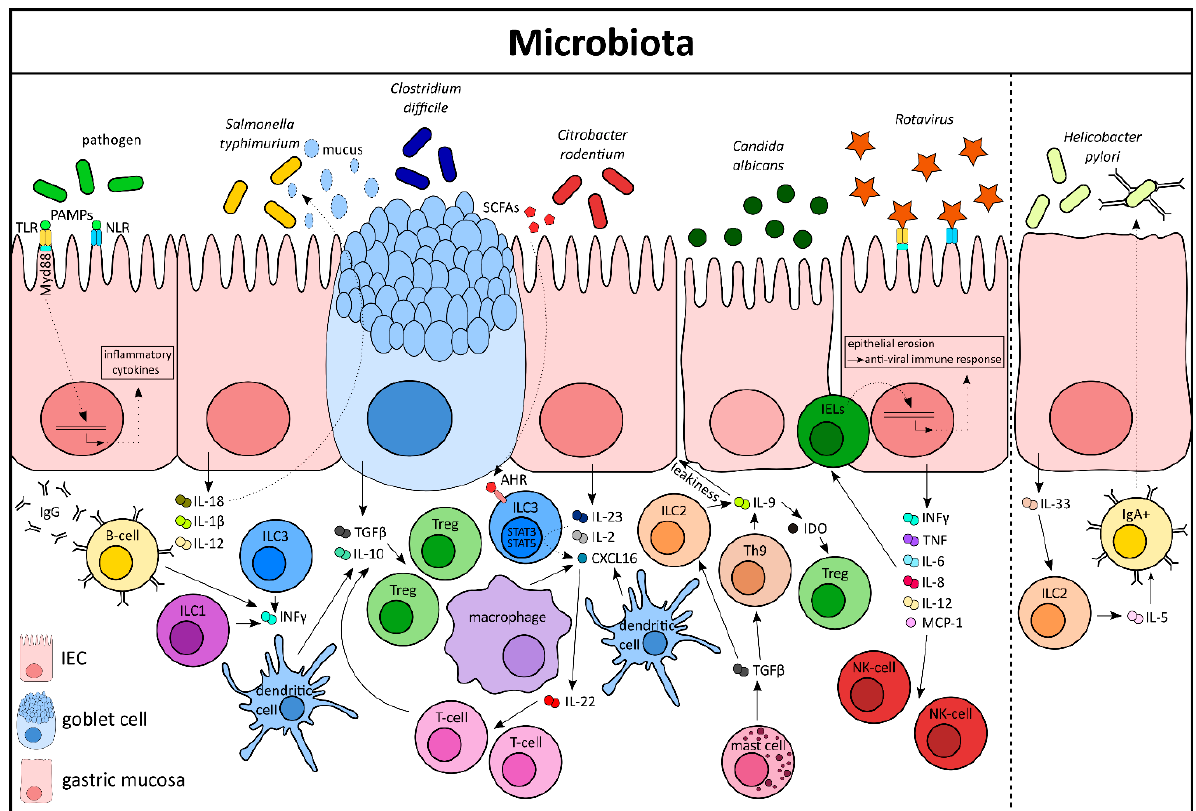
Figure 2. Cytokine signaling between intestinal epithelial cells and immune cells regulate the host response to infections. AHR, Aryl hydrocarbon receptor; IDO, indolamin-2,3-dioxygenase; IELs, intraepithelial lymphocytes; MCP-1, monocyte chemoattractant protein-1; NLR, NOD-like receptor; PAMPs, pathogen-associated molecular patterns; SCFAs, short-chain fatty acids; TLR, Toll-like receptor.